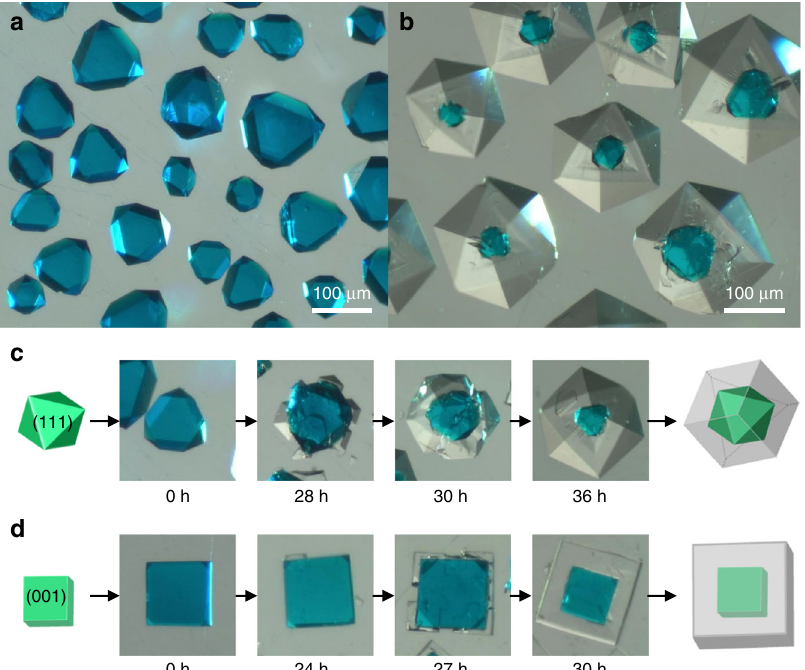
Fig. 3 Formation of HKUST-1@MOF-5 from the HKUST-1 crystal. a Optical microscope image of the octahedral HKUST-1 crystal. b Single crystalline HKUST-1@MOF-5. c Growth process of the single crystal HKUST-1@MOF-5 from octahedral HKUST-1 for different times. d Growth process of